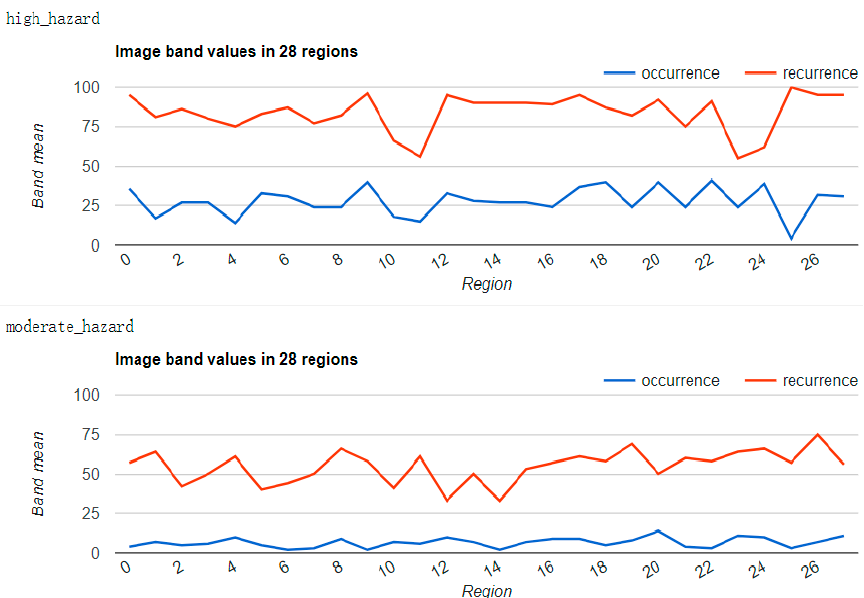
Figure 11. The band values of 28 points in high hazard, moderate hazard, low hazard zones,